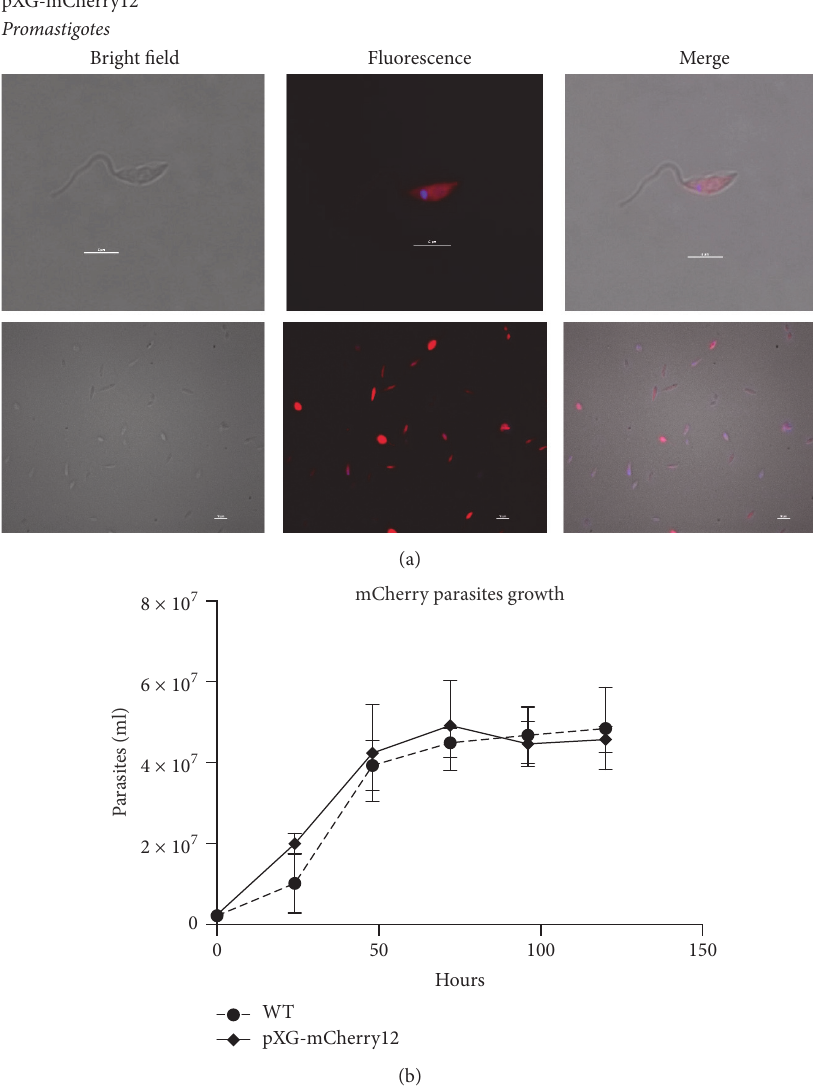
Figure 2: L. major pXG-mCherry12 parasites stably expressing the red fluorescent protein, upholding the same growth rate as the WT strain. (a) Fluorescent detection of red fluorescent parasites by confocal microscopy. Top lane, single parasite acquisition (100x objective). Bottom lane, more parasites per field (40x objective). Microscopy images were acquired with a Nikon Eclipse E800 confocal microscope. (b) Wild type strain and pXG-mCherry12 transfected parasites growth curve. Growth was measured during 6 days for WT (filled circle “ e ”) and pXG-mCherry12 (filled diamond “ X ”) transfected parasites cultures. Data represents the mean ( ± SD) of three independent